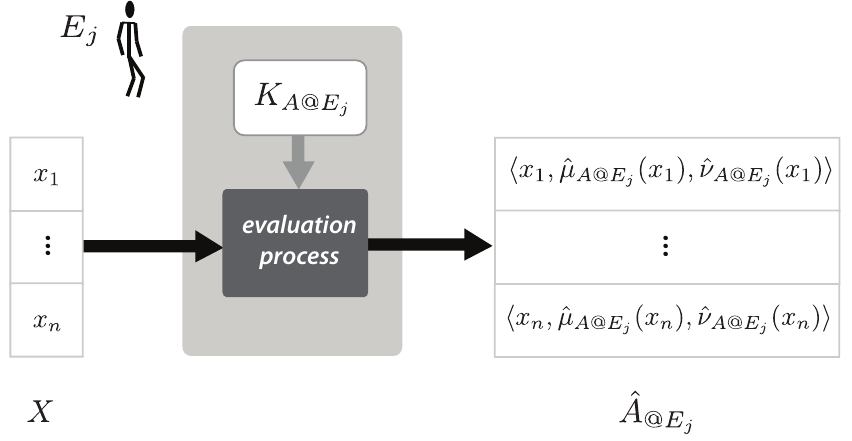
Figure 1. Contextualized evaluations ˆ A @ E ‘ x i IS A ’ performed by Expert E j according to the expert’s knowledge K A @ E